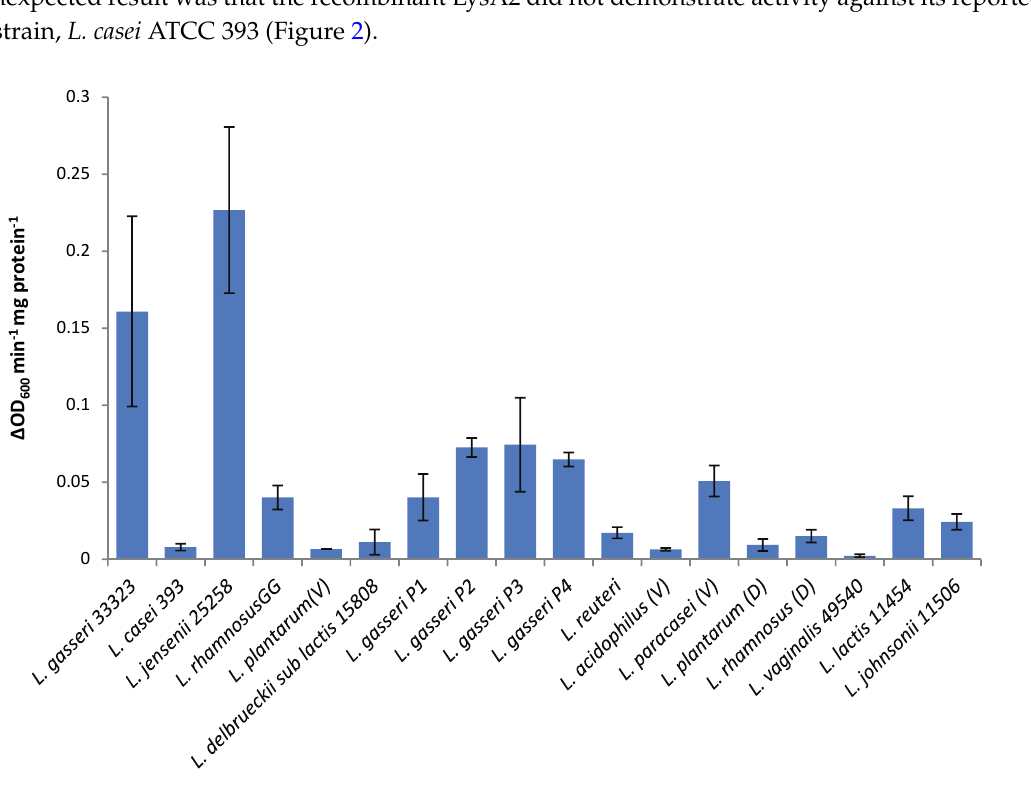
Figure 2. Specific activities of LysA2 against different Lactobacillus sp. Specific activity was calculated as described in Material and Methods. Strains are listed in Table 1. All experiments were performed in triplicate and error bars indicate standard error.